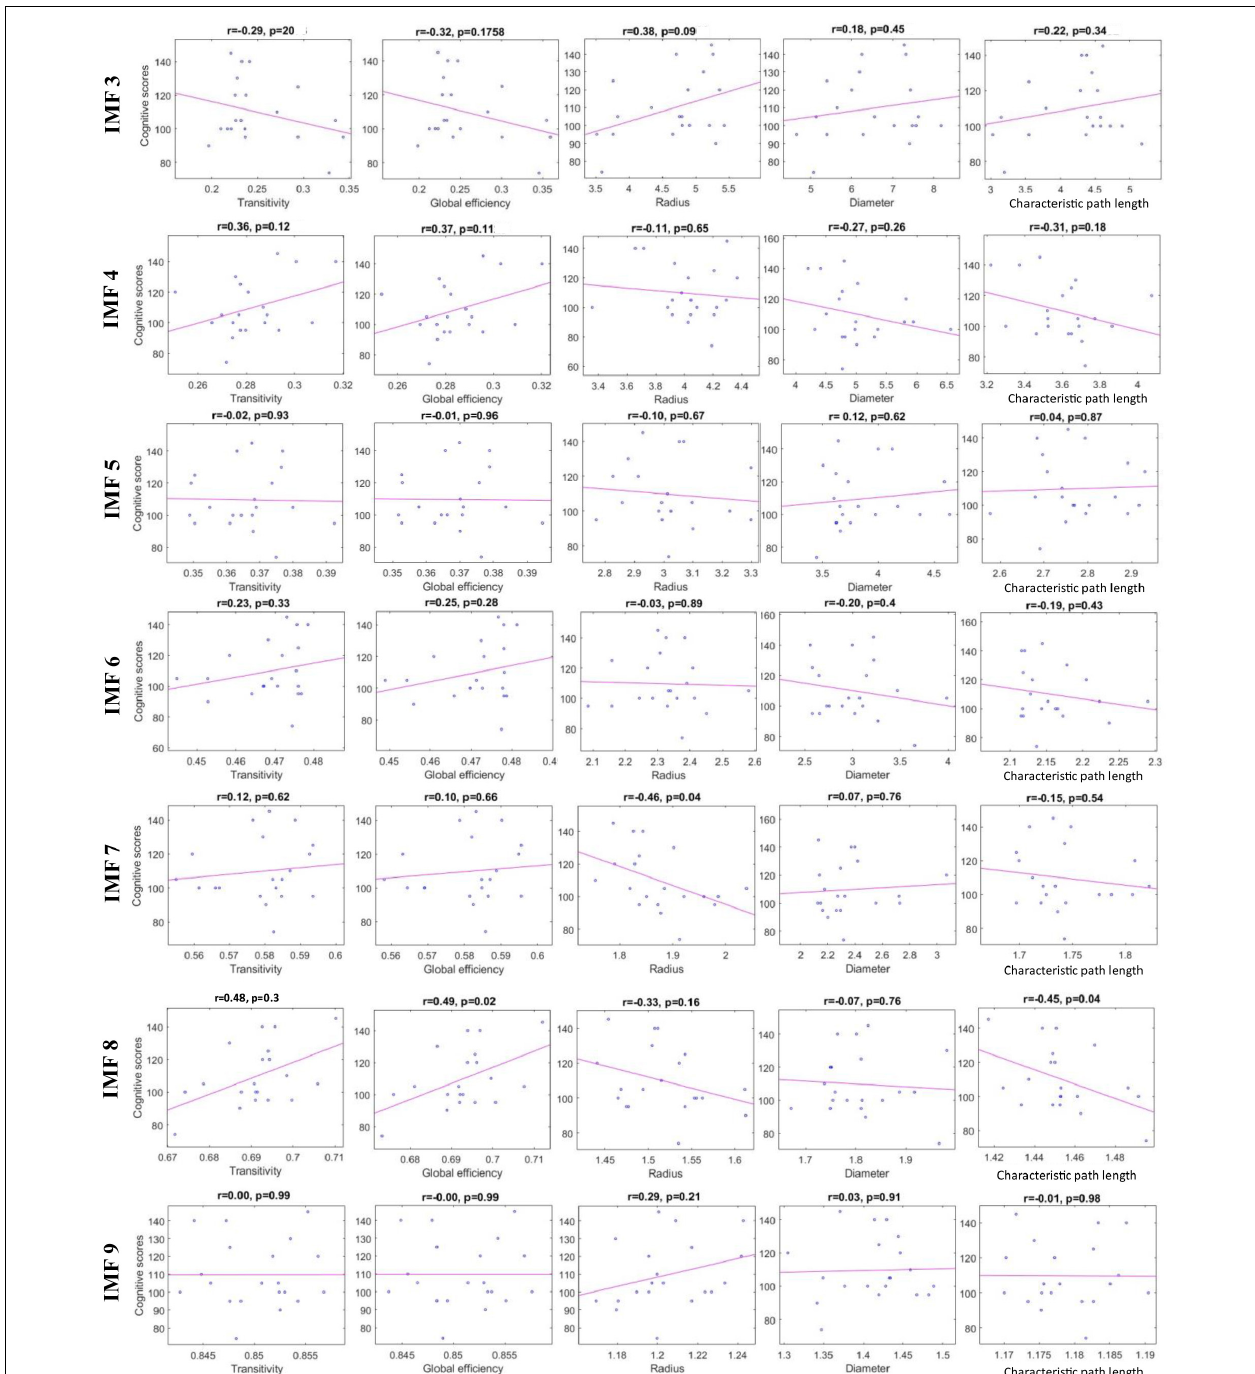
FIGURE 5 | Scatter plots representing the correlation between the graph-theoretical features calculated from each IMF and cognitive scores.